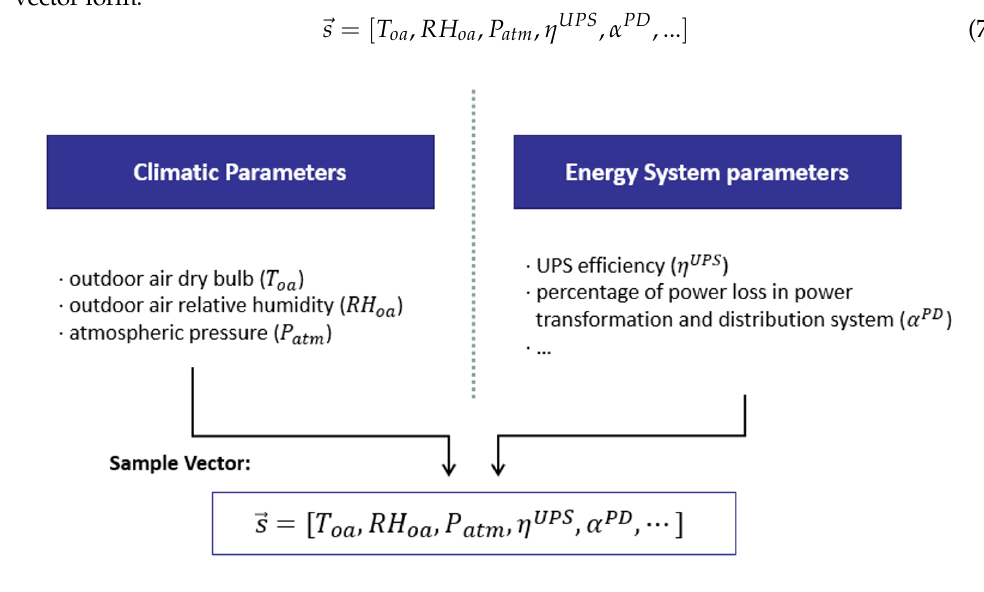
Figure 2. Generation of example